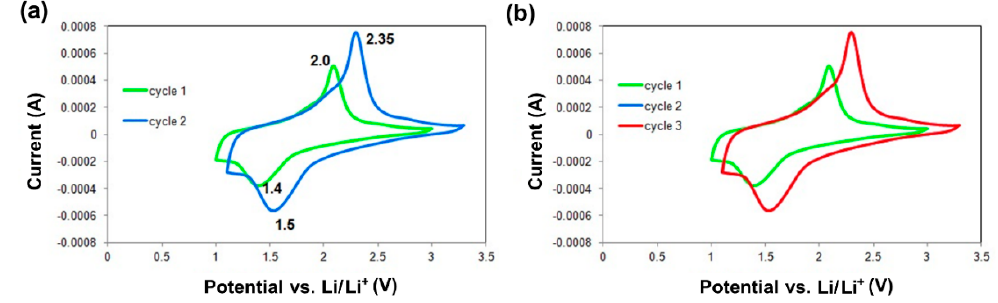
Figure 12. Cyclic voltammograms at a scan rate of 0.5 mV/s for Ti5Mo5 forming a composite